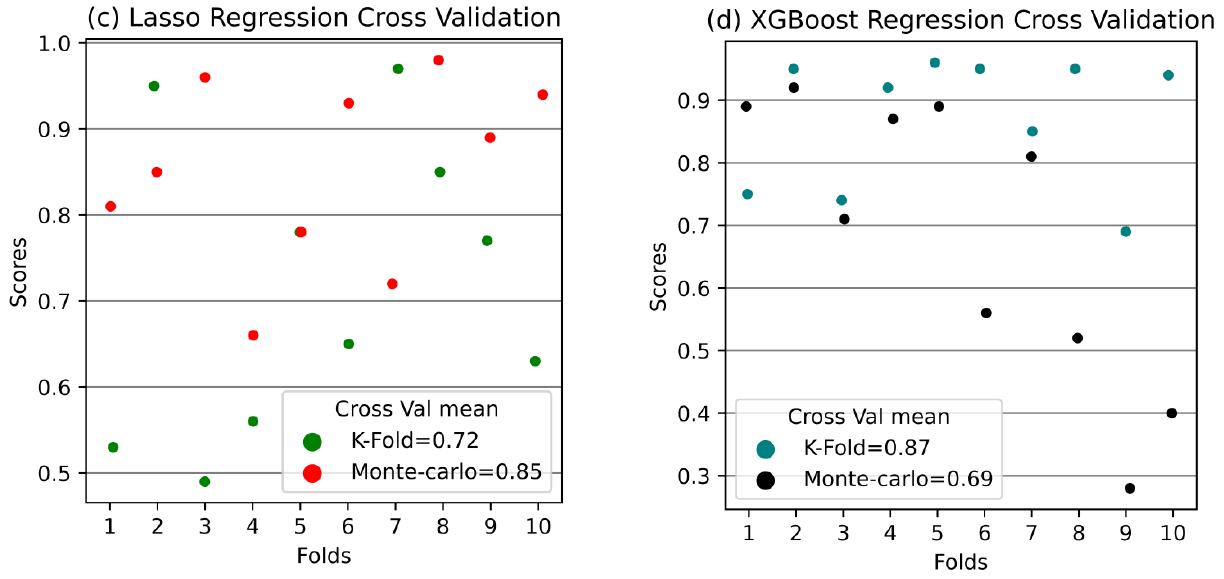
Figure 9. ( a – d ): K-Fold and Monte-Carlo Cross-validation Mean R 2 Scores.